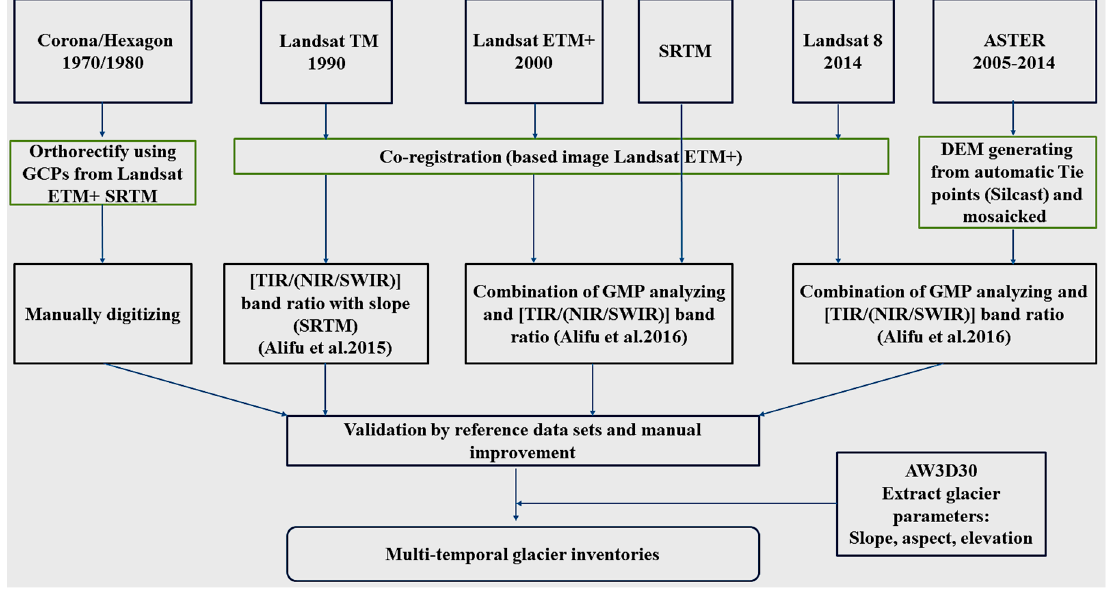
Figure 4. Schematic flowchart for generation of multi-temporal glacier inventories.